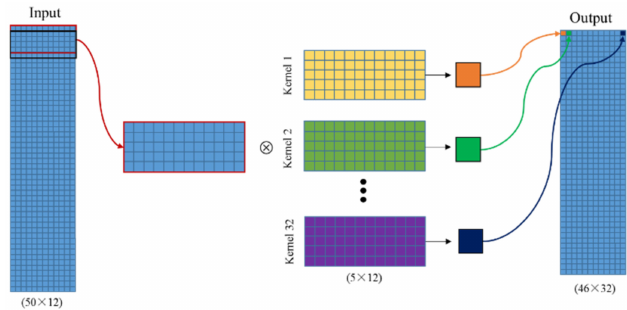
Figure 4. Convolution operation diagram.